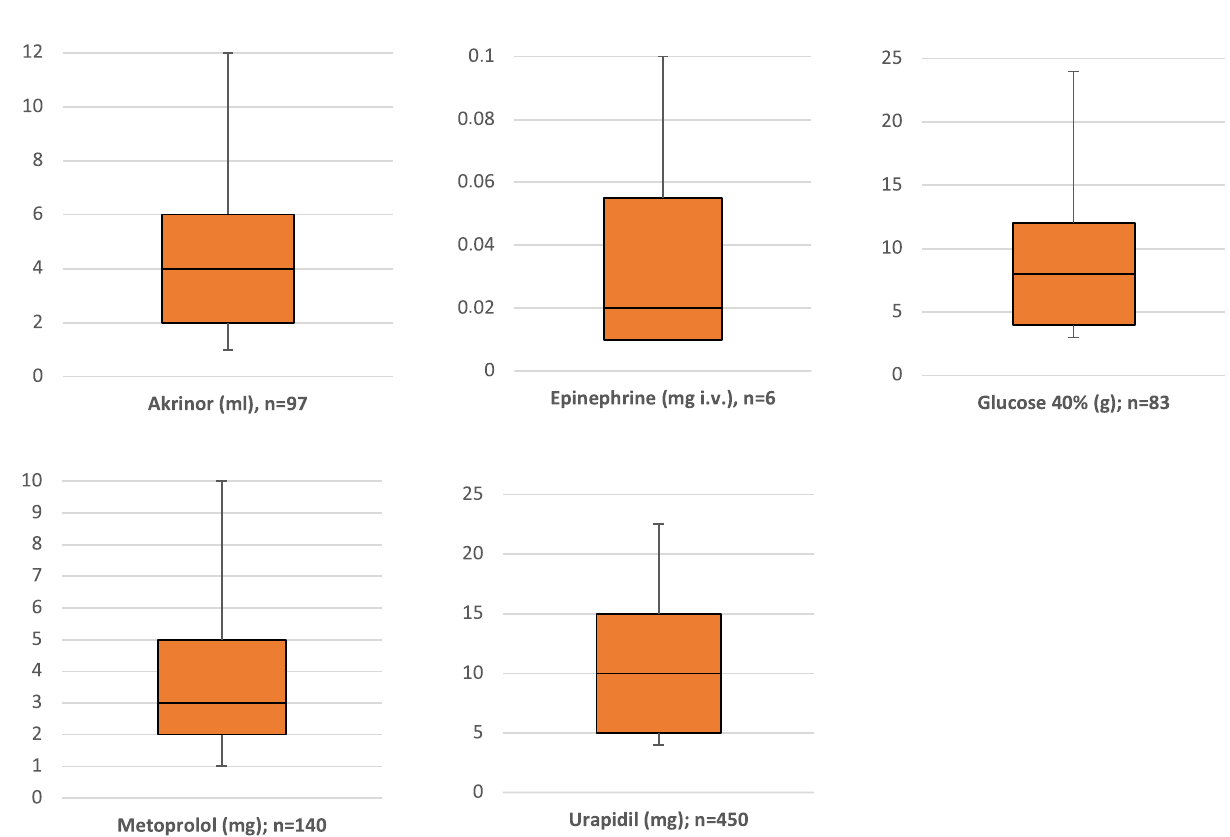
Figure 3. Drugs administered with the average cumulative dose per mission. Akrinor is a combination product containing both Cafedrin and Theodrinaline (200/10 mg/ml); ml = milliliter, mg = miligram, g = gram. Overall documentation quality of vital signs (n = 4293) Absolute number of missing values (n) Relative portion of missing values